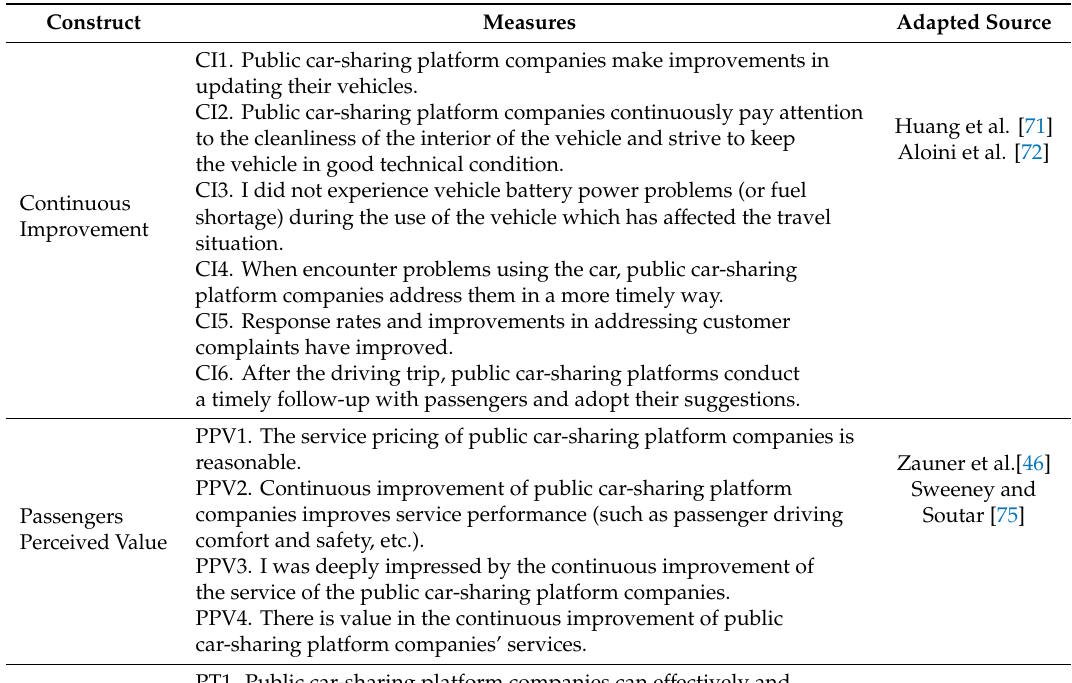
Table 1. Construct, Measures, and